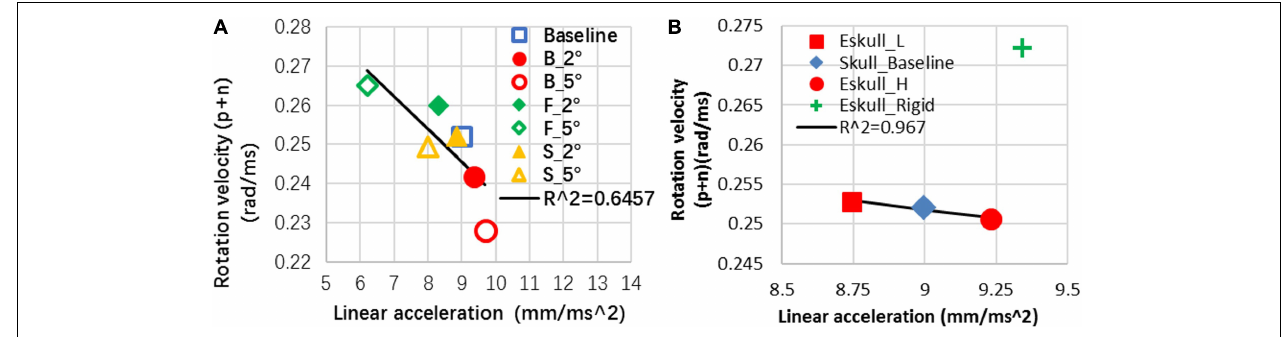
FIGURE 7 | (A) Rat head kinematics was inversely correlated between the angular motion and linear motion in response to the helmet angle change; (B) head kinematics of skull effect (P.S The data point of Eskull_Rigid is excluded to show the negative relationship of other three cases in this